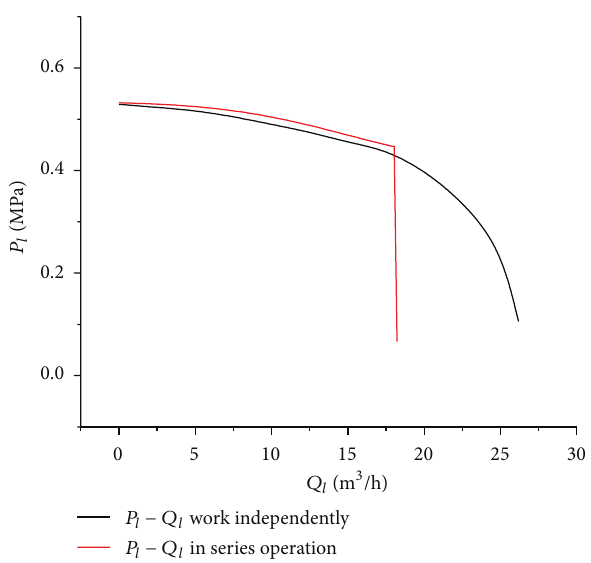
Figure 10: Comparison of performances of centrifugal